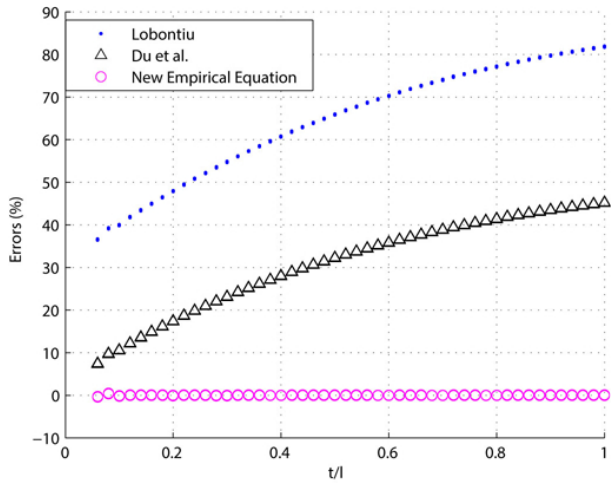
Figure 15. Errors of comparison results.